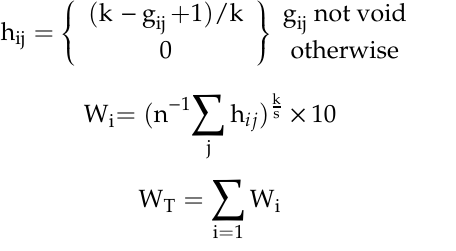
Table 3. Ranking score h ij for raw ranking g ij of the rater’s most preferred k attributes. g ij k